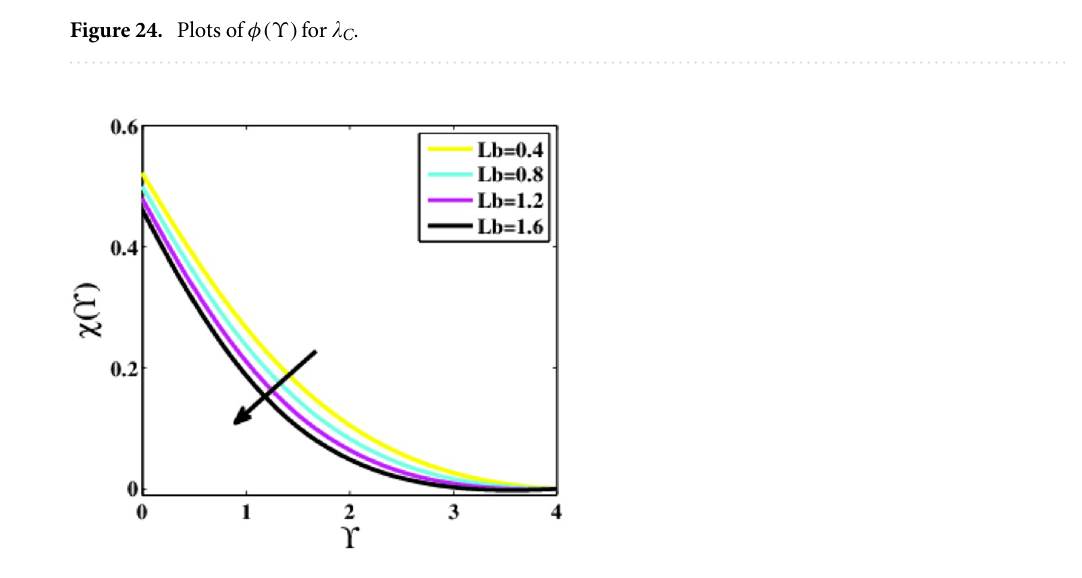
Figure 25. Plots of χ(ϒ) for Lb